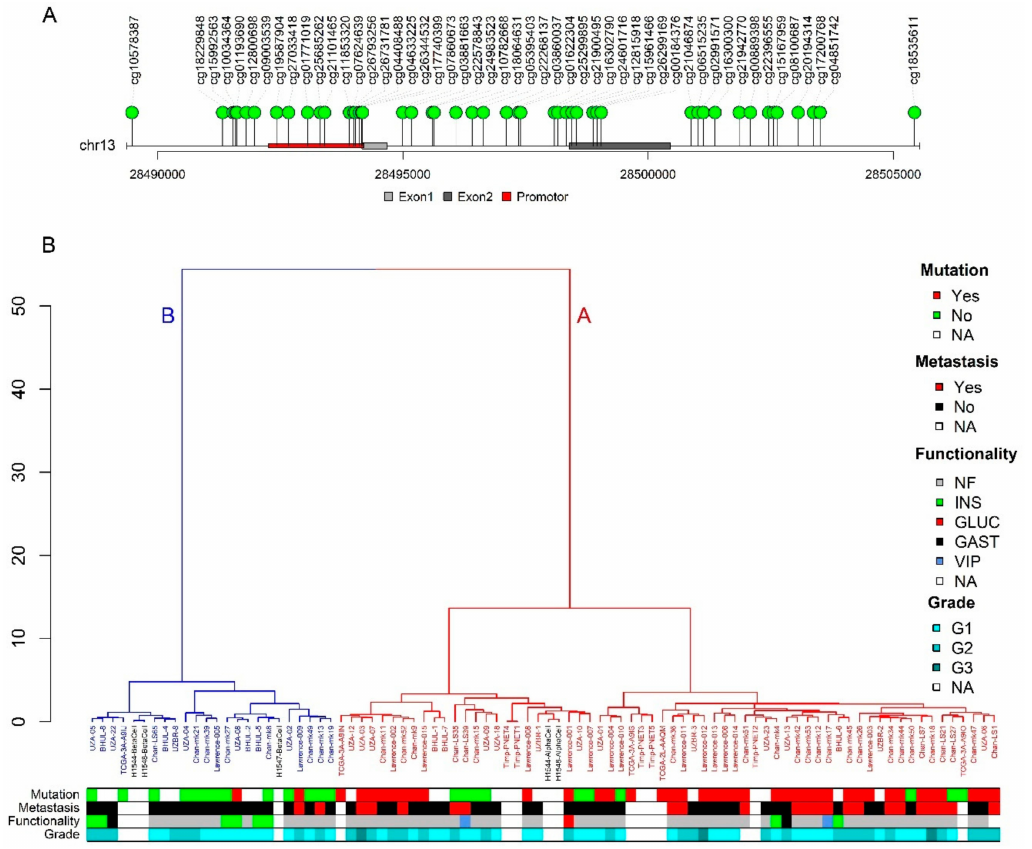
Figure 3. DNA methylation of the PDX1 gene region can be used to perform subtyping. ( A ) Layout of the PDX1 gene region with the CpG probes (green lollipops) that have been used for the clustering. ( B ) Unsupervised hierarchical clustering of the available PNEN, alpha cell (black) and beta cell (black) samples. Two groups can be distinguished, group A (in red), which contains the alpha cells and subtype A PNENs, and group B (in blue), which contains the beta cells and subtype B PNENs. Additional clinicopathological characteristics, e.g., mutation status of ATRX / DAXX / MEN1 , presence of distance metastasis at diagnosis, functionality and WHO Grade (G1-3), are shown for the samples. (NA, not applicable or information not available; NF, non-functional; INS, insulinoma; GLUC, glucagonoma; GAST, gastrinoma; VIP,